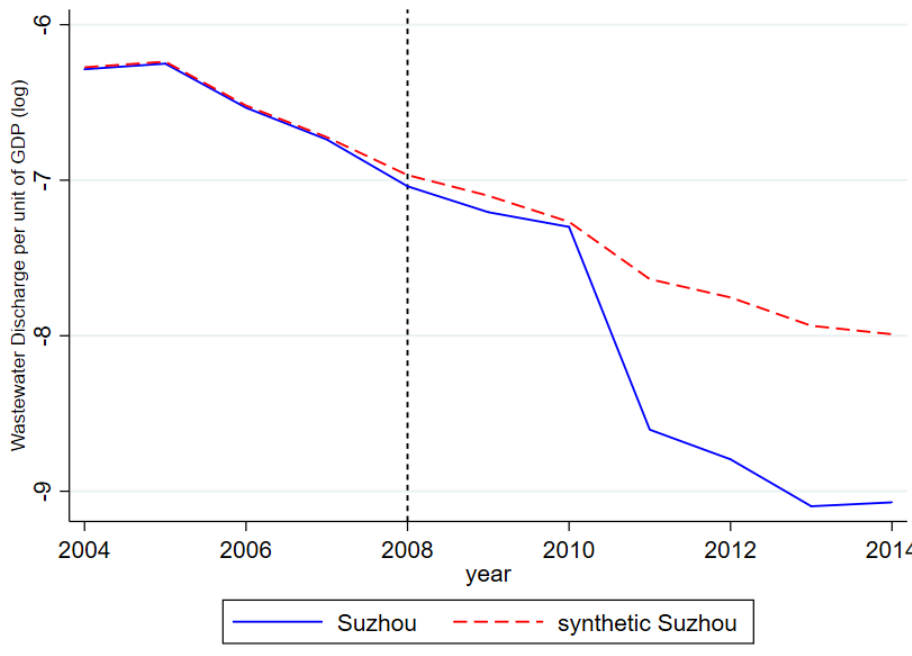
ff ects of Suzhou and synthetic Figure 5. Policy effects of Suzhou and synthetic Suzhou. Figure 5. Policy e